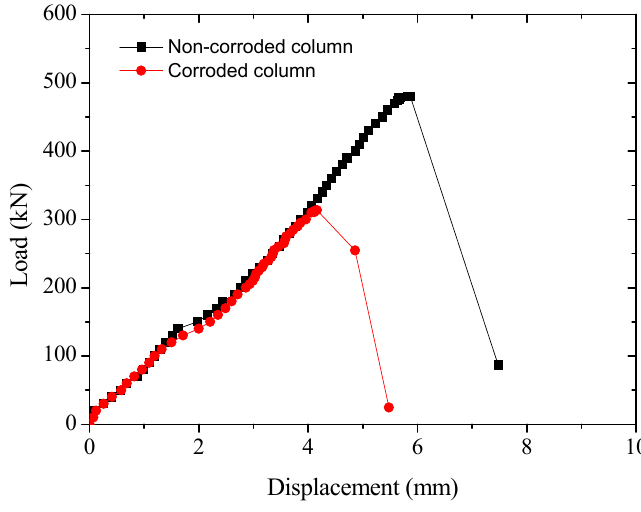
Figure 8. Load-vertical displacement response of RC specimens.